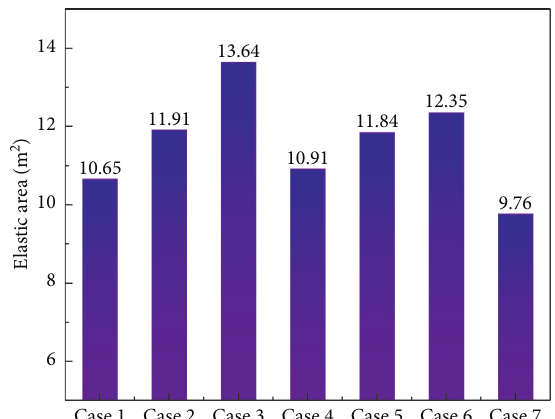
Figure 12: Elastic zone area in the roof.